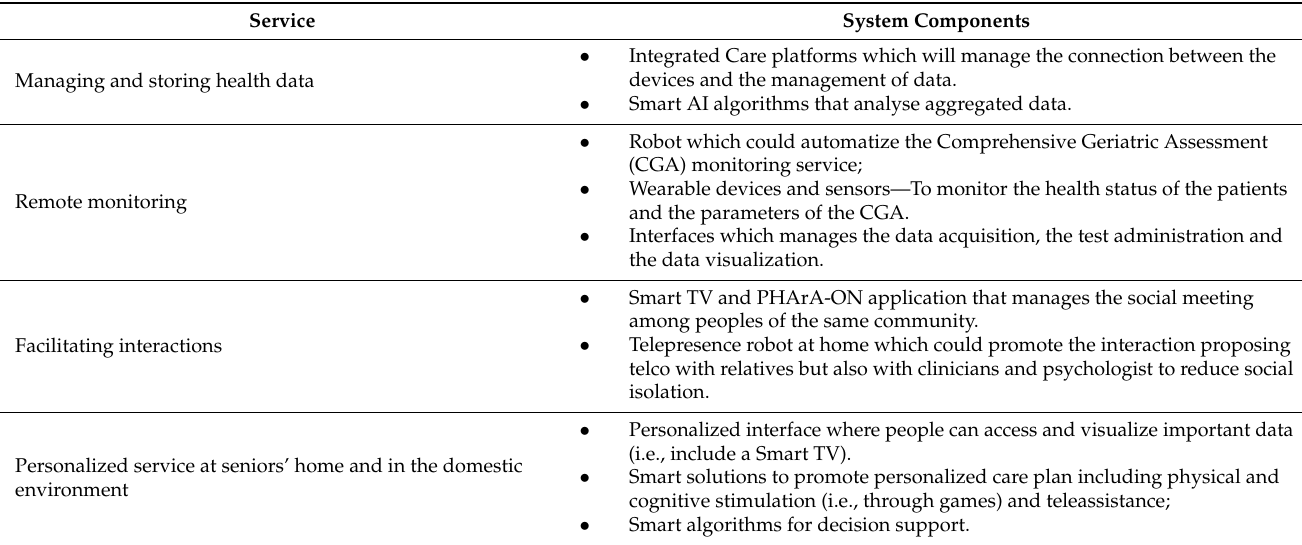
Table 2. Overview of system components.